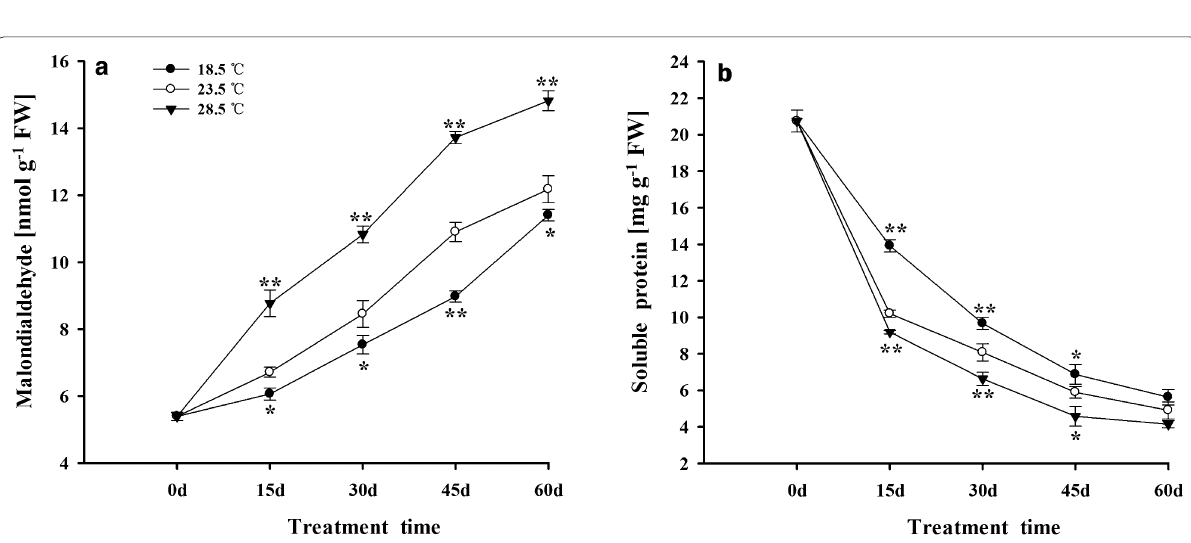
Fig. 3 Effects of different growth temperatures on contents of MDA ( a ) and soluble protein ( b ) in tobacco